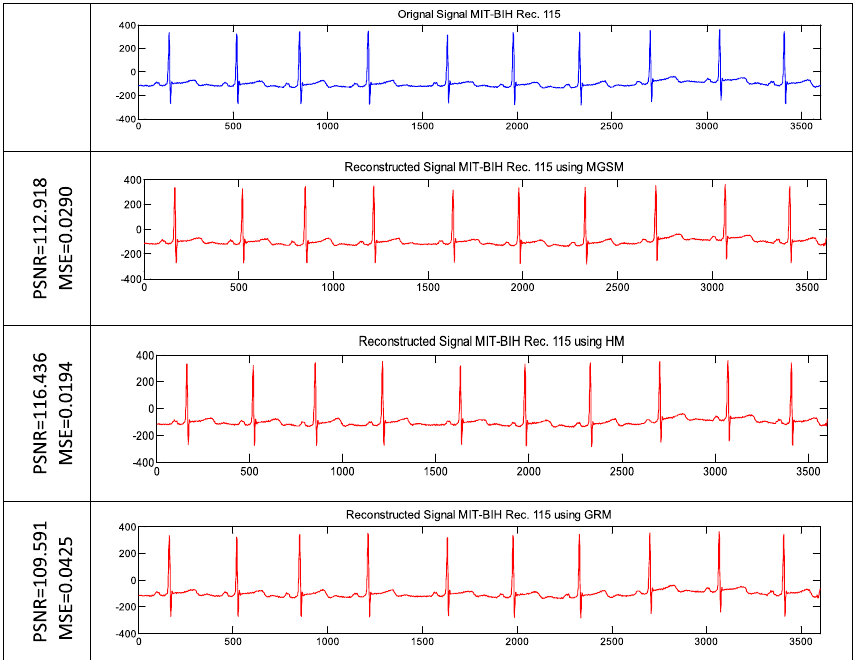
Fig. 4 Set of reconstructed “Rec. 115” signal using Tchebichef moments with Gram–Schmidt, Householder, and Given Rotations